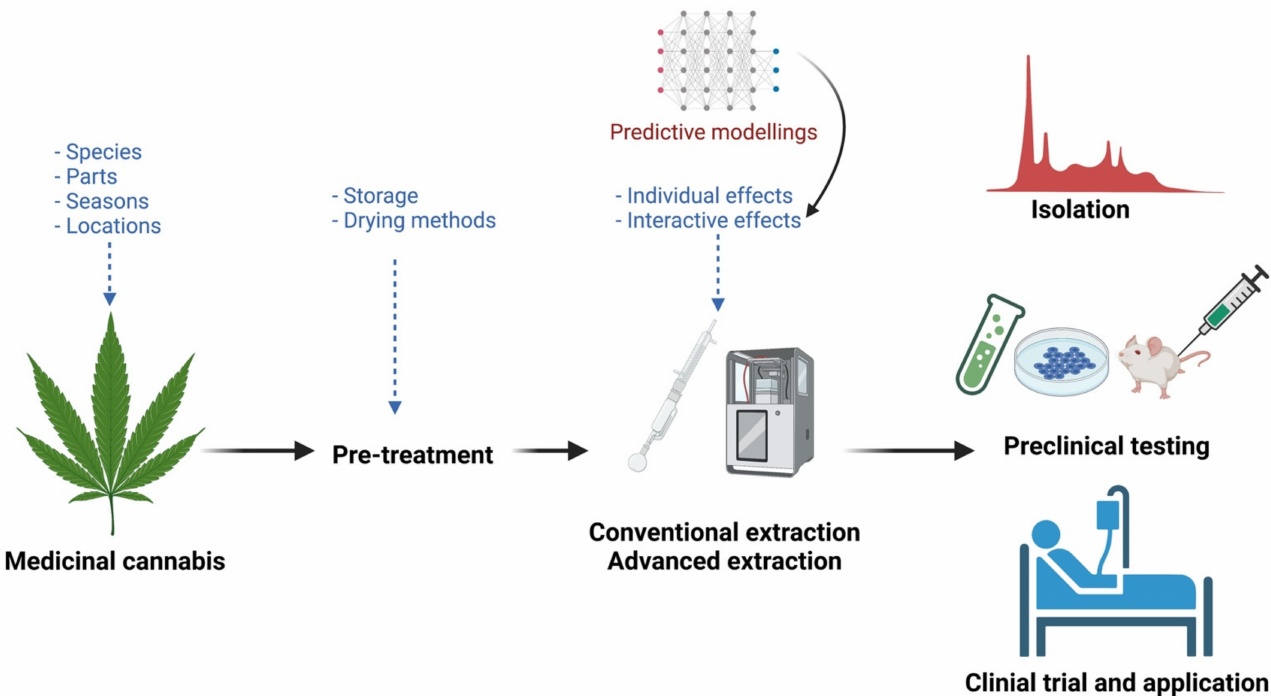
Figure 4. Proposed gaps for future